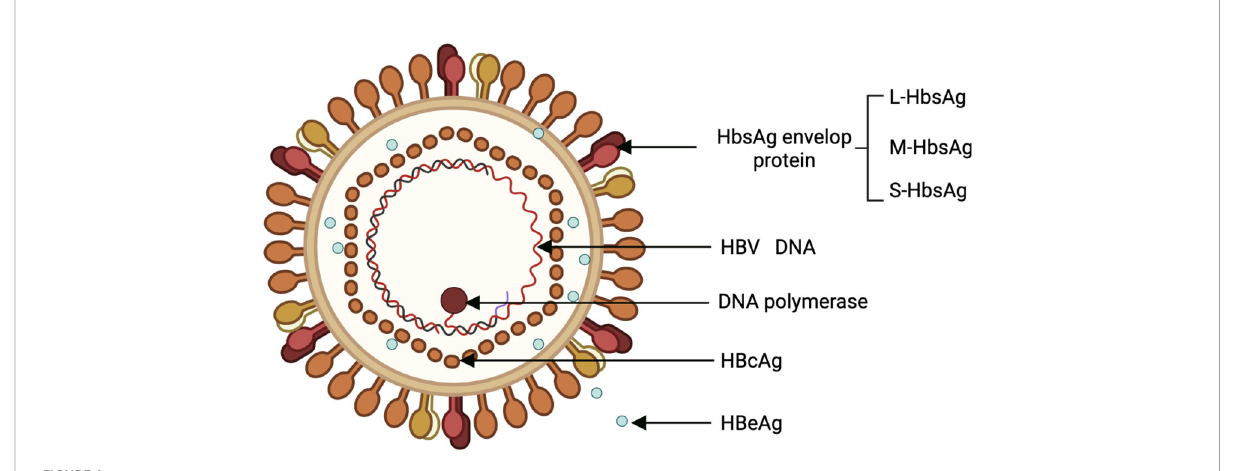
FIGURE 1 Structural of HBV. HBV, Hepatitis B